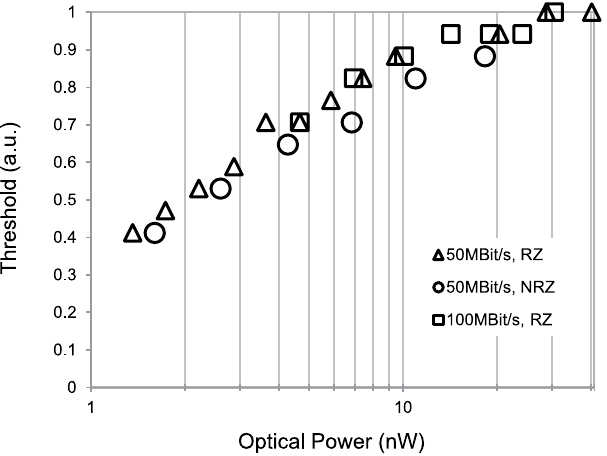
Figure 10. Optimized decision threshold over average optical input power for analog